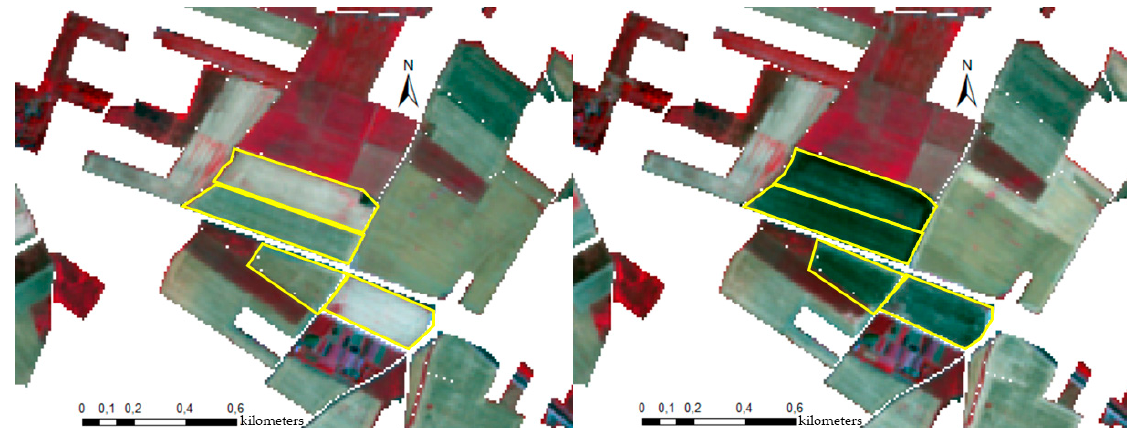
Figure 9. Infrared colored composite image (R:8, G:4, B:3) before ( left ) and after ( right ) green waste compost amendment. The fields with information on EOM spreading are delineated in yellow. White areas are non-agricultural areas.